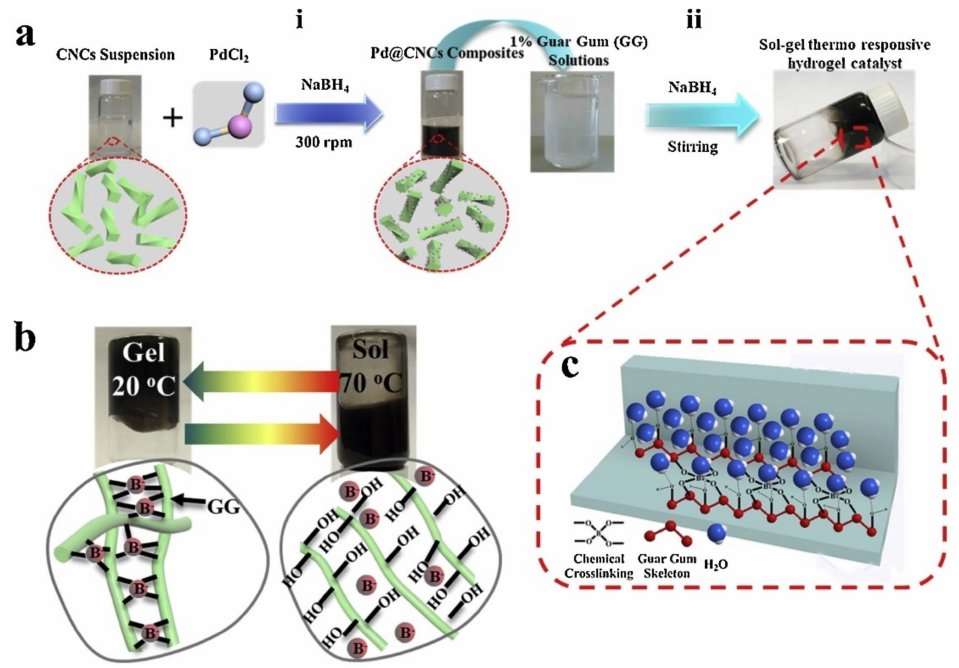
Figure 3. Schematic of thermo-responsive PdNPs@ CNCs/guar gum hydrogel catalyst system ( a ): (i). Formation of PdNPs@ CNCs composites (ii). Preparation of PdNPs@ CNCs/guar gum hydrogel. ( b ) Thermo-responsive guar gum hydrogel: hydrogel transferred to sol state at high temperature (over 70 ◦ C), and returned to gel state when cooled down (below 20 ◦ C). ( c ) Boron-based crosslinking in the Guar gum hydrogel matrix [26]. Copyright Elsevier,